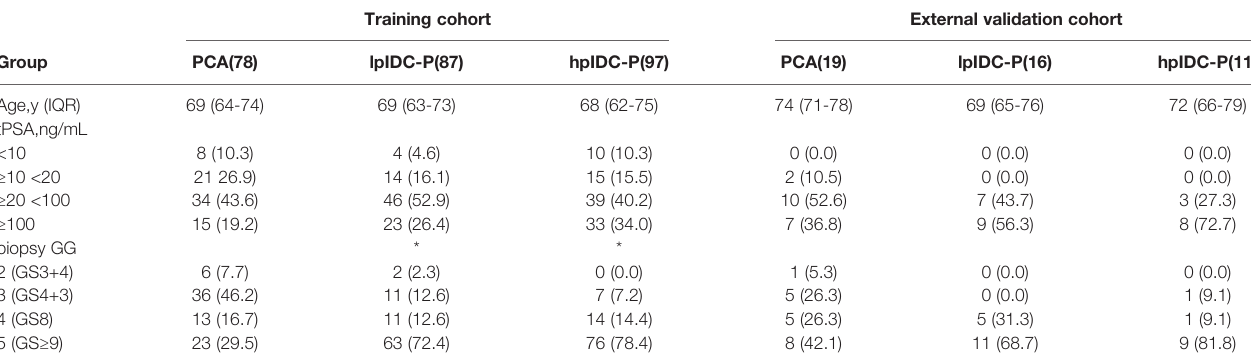
TABLE 1 | The clinicopathological data of patients in training and external validation cohorts. Training cohort External validation cohort